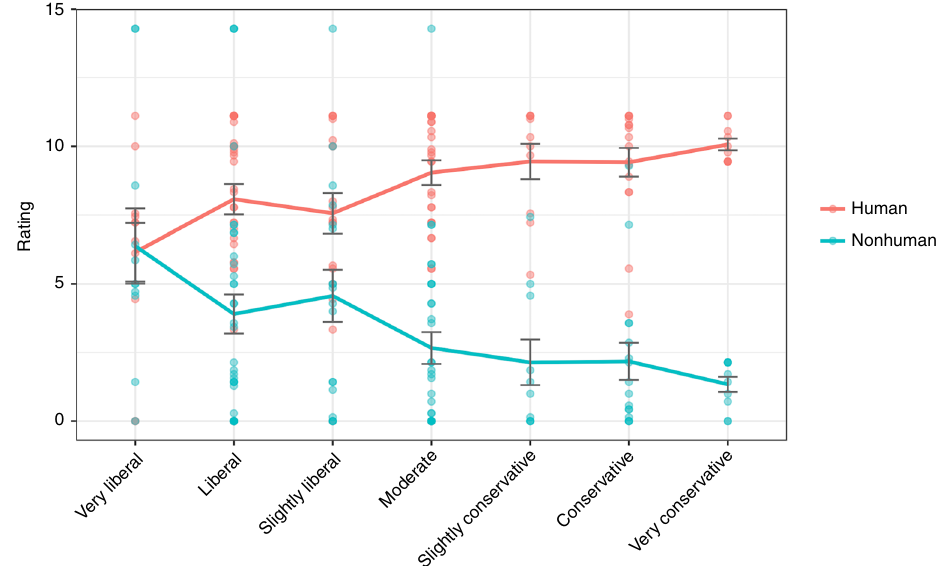
Fig. 4 Personal moral allocation to humans and nonhumans by political ideology, Study 3a. Error bars represent standard errors, solid lines indicate means. Source data are provided as a Source Data fi le